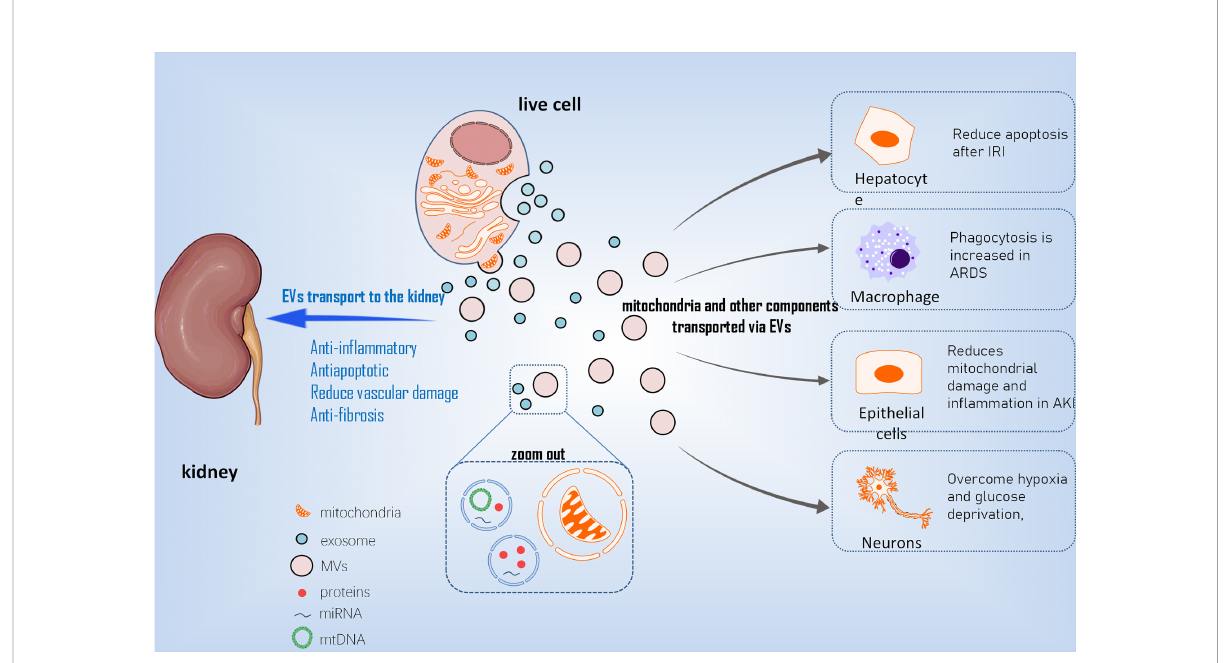
FIGURE 2 The mechanism of EVs transporting mt into different cells. EVs, extracellular vesicles; mt, mitochondria; MVs, Microvesicles; IRI, ischemical reperfusion injury; ARDS, acute respiratry distress syndrome; AKI, acute kidney